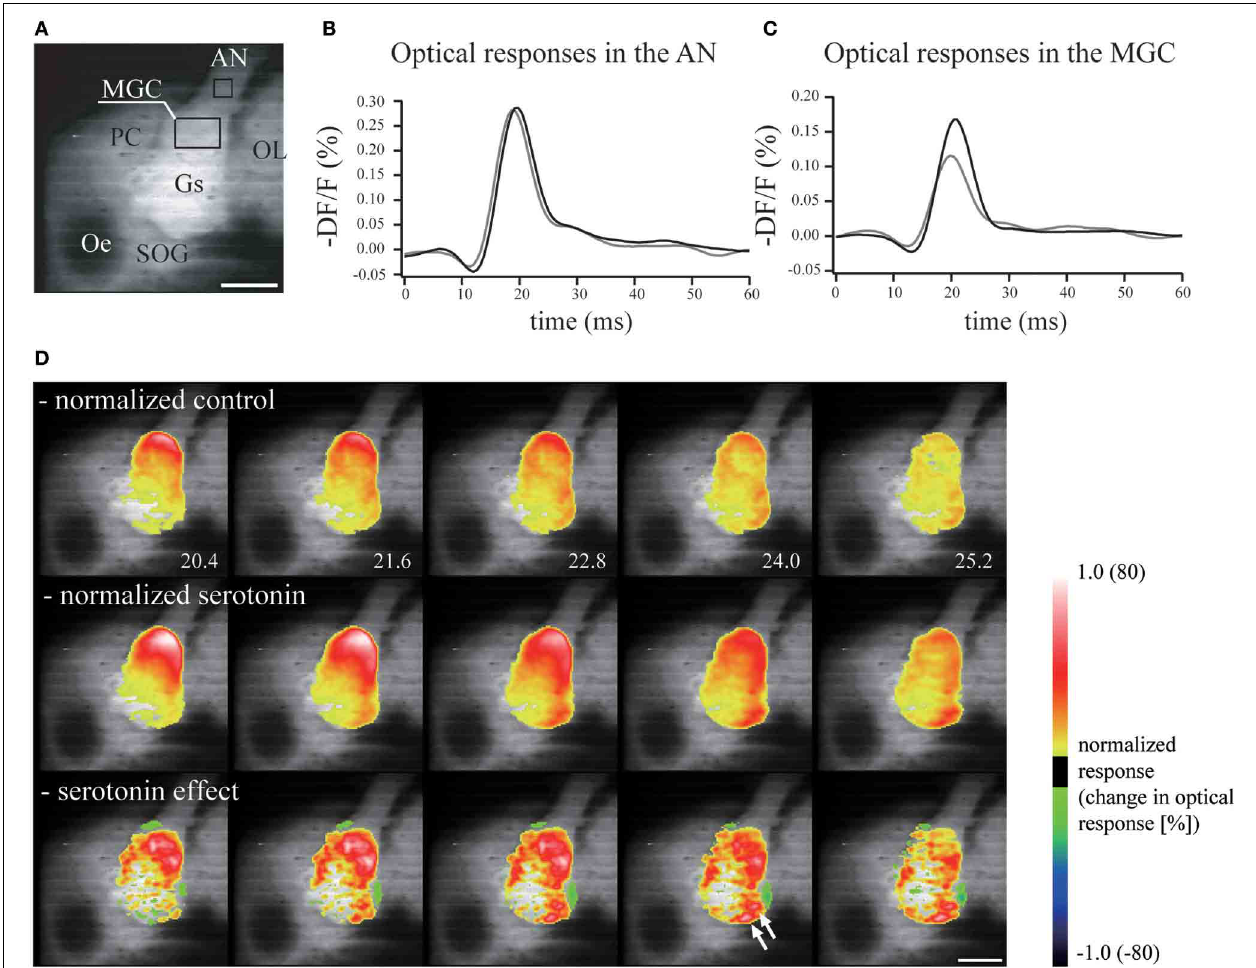
FIGURE 8 | Serotonin enhances the neural activity of the antennal lobe. (A) Real image of the brain demonstrating the regions from which measurements of the neural activity were made in the antennal nerve and the macroglomerular complex. Scale bar = 200 μ m. AN, antennal nerve; AL, antennal lobe; Gs, ordinary glomeruli; MGC, macroglomerular complex; Oe, esophagus; OL, optic lobe; PC, protocerebrum; SOG, suboesophageal ganglion. (B) Serotonin had no effect on the optical response in the antennal nerve. Gray line, control response; black line,